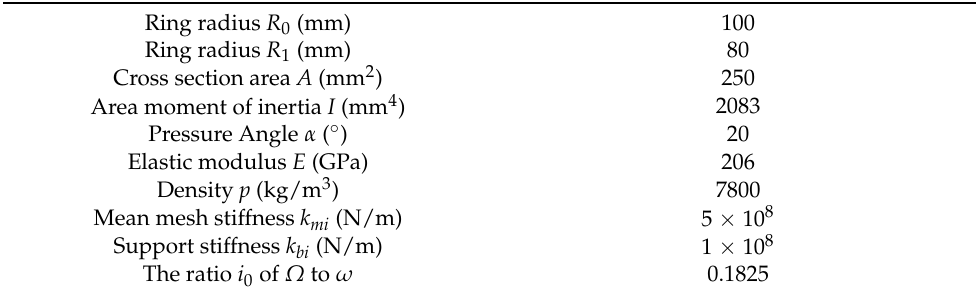
Table 1. Parameters of a planet ring with discrete and partially distributed